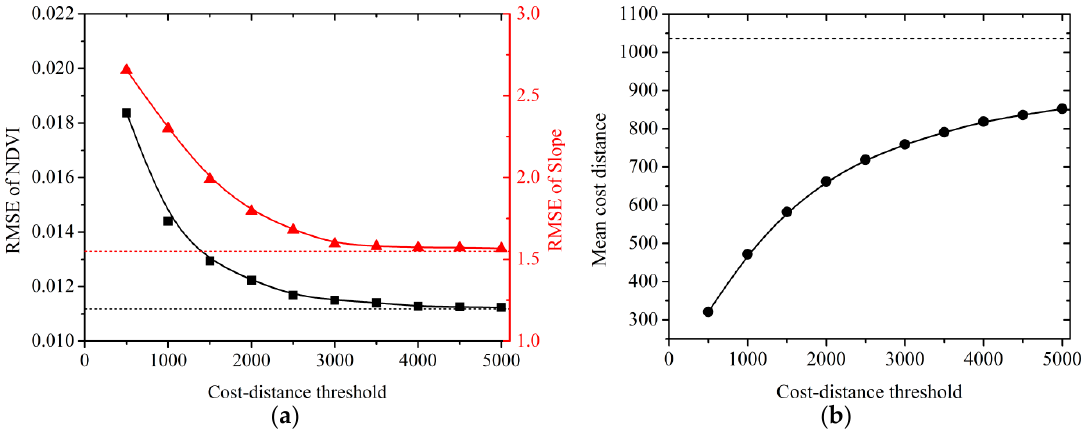
Figure 3. RMSEs of NDVI and slope ( a ) and mean cost-distance ( b ) as a function of the cost-distance threshold with the sample number equal to 30. The dashed lines in ( a ) represent the RMSEs of NDVI and slope from conditioned Latin hypercube sampling without cost constraints (CLH), and the dashed line in ( b ) represents mean cost-distance to reach the sampling points from CLH.